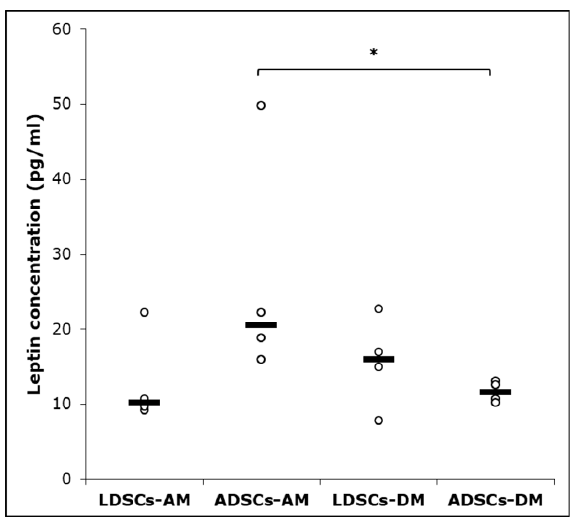
Figure 7. Leptin concentration in cell culture supernatant of LDSCs and ADSCs measured by ELISA at day 21 of adipogenic differentiation; scatterplots with median; n = 4 for all groups; (*) p < 0.05. Cells 2018 , 7 , x FOR PEER REVIEW 12 of 23